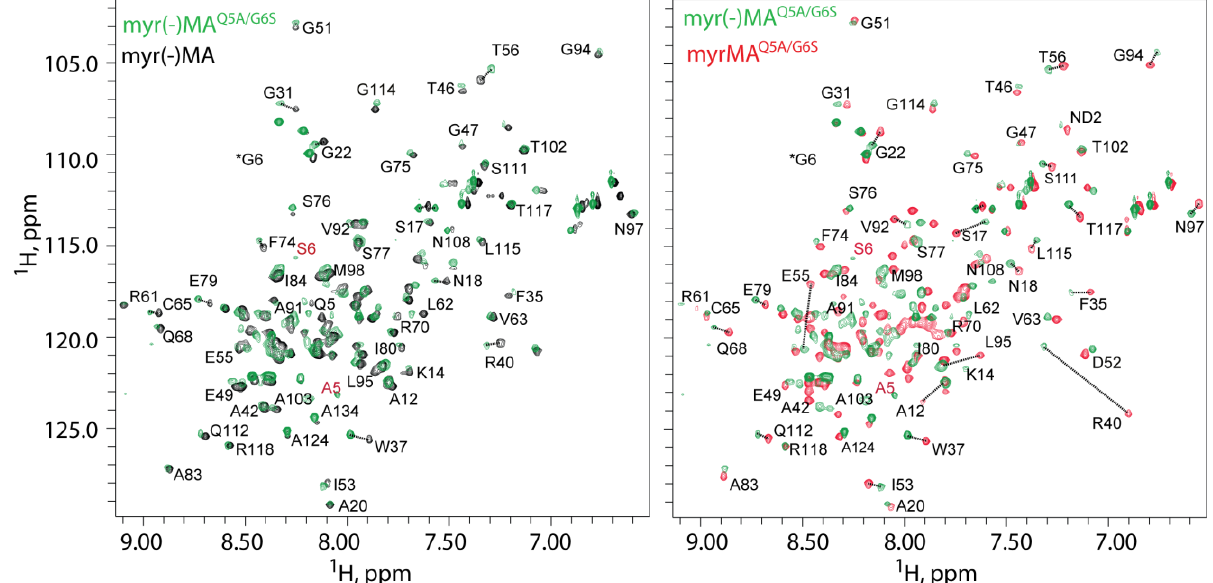
Figure 2. 1 H- 15 N HSQC of FIV myr(-)MA Q5A/G6S (green) overlaid with wild-type FIV myr(-)MA (black, on left) and FIV myrMA Q5A/G6S (red, on right). Residues marked in red indicate mutated residues (A5, S6). Asterisk denotes peak present in lower levels. 2D 1 H- 1 H NOESY, 3D 15 N edited NOE, and 2D 1 H- 13 C HMQC NOE data obtained for